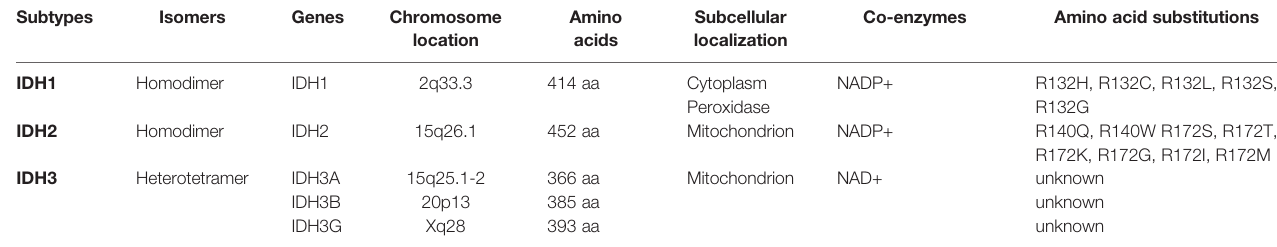
TABLE 1 | IDH Structures and Biochemical